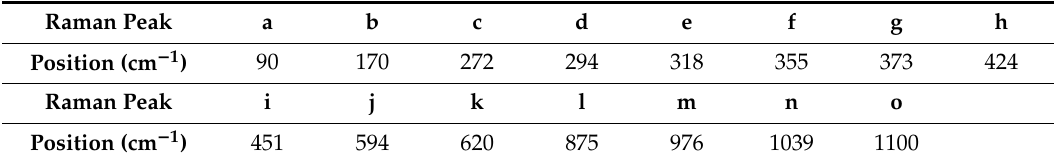
Figure 1. Raman spectra of chalcopyrite before and after leaching for 14 ( a , b ) and 42 days ( c , d ) at pH 1 in the presence of ferrous and ferric. , fresh chalcopyrite. (cid:192) to (cid:200) in ( a ) to ( d ) correspond to Raman spots shown in Figure 2. Table 1. Raman peaks observed for chalcopyrite before and after leaching at pH 1 in ferric and ferrous solutions.